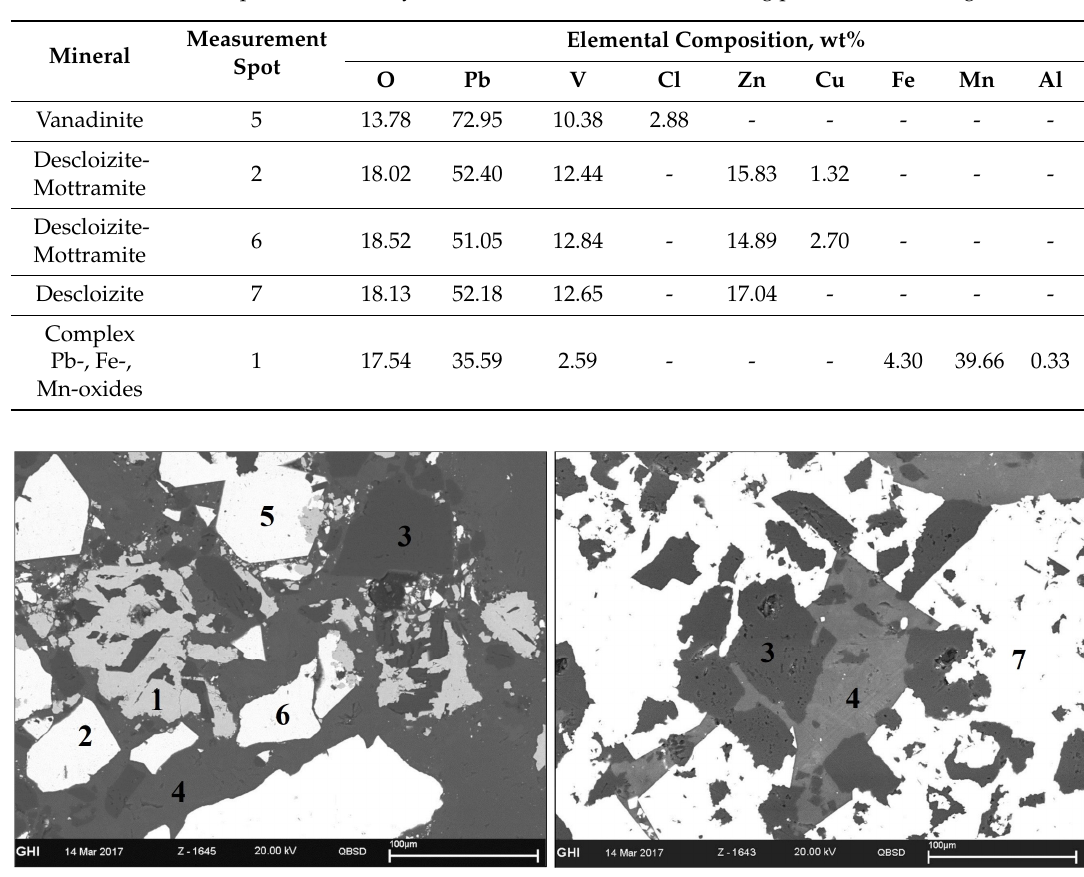
Figure 5. Backscattered electron images (BSE) of main ore specimens with locations of complex Pb-, Fe-, Mn-oxides (1), Descloizite-Mottramite (2, 6), Dolomite (3), Calcite (4), Vanadinite (5), Descloizite (7).